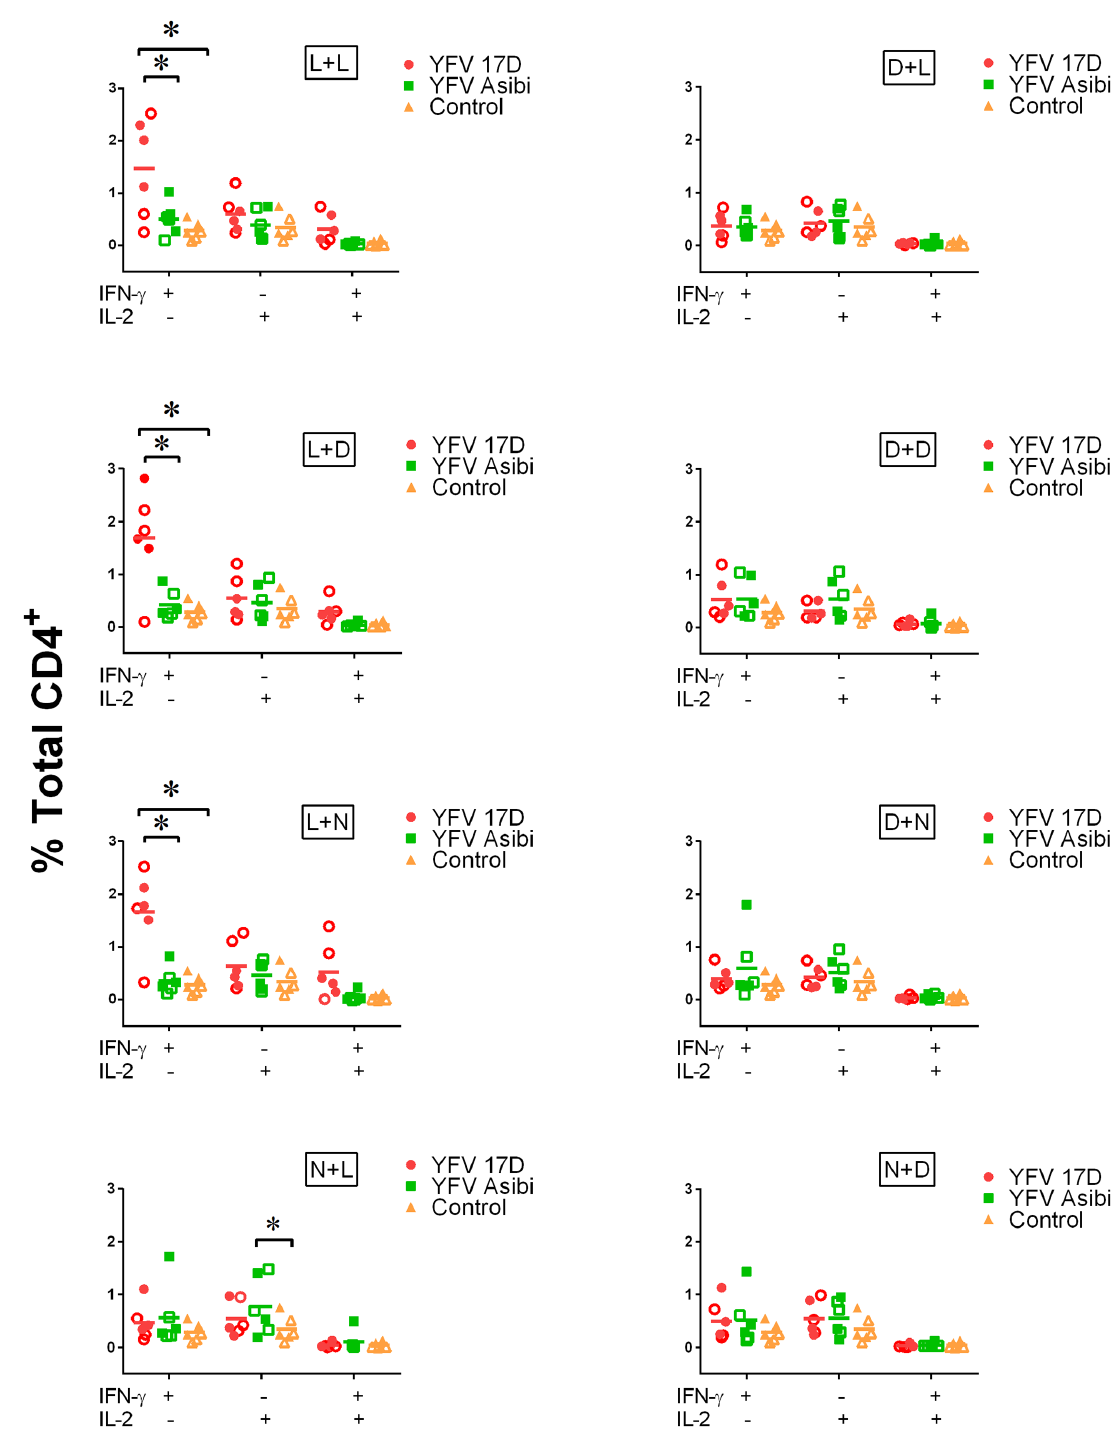
Fig 8. Cytokine response in CD4 + T cells: Wild-type Asibi virus vs. vaccine 17D virus infection. IFN- γ and IL-2 production by human CD4 + T cells in re-stimulation assays. Each data point represents the response from an individual donor (n = 6) with the horizontal bar indicating the mean of the six values. Red data points indicate 17D YFV-treated cells, green squares indicate Asibi YFV-treated cells and yellow triangles indicate mock-treated cells. Closed data points indicate cells from unvaccinated donors while open data points indicate cells from vaccinated donors. (L) indicates treatment with live virus, (D) indicates treatment with gamma-irradiated inactivated virus and (N) indicates mock-treated MoDC prior to co-culturing with CD4 + T cells (See Fig 7 and Materials and Methods). ( * ) indicates points of significant (p < 0.05) difference between the indicated datasets (bracket). A non-parametric multi-T test was used to determine statistical significance.